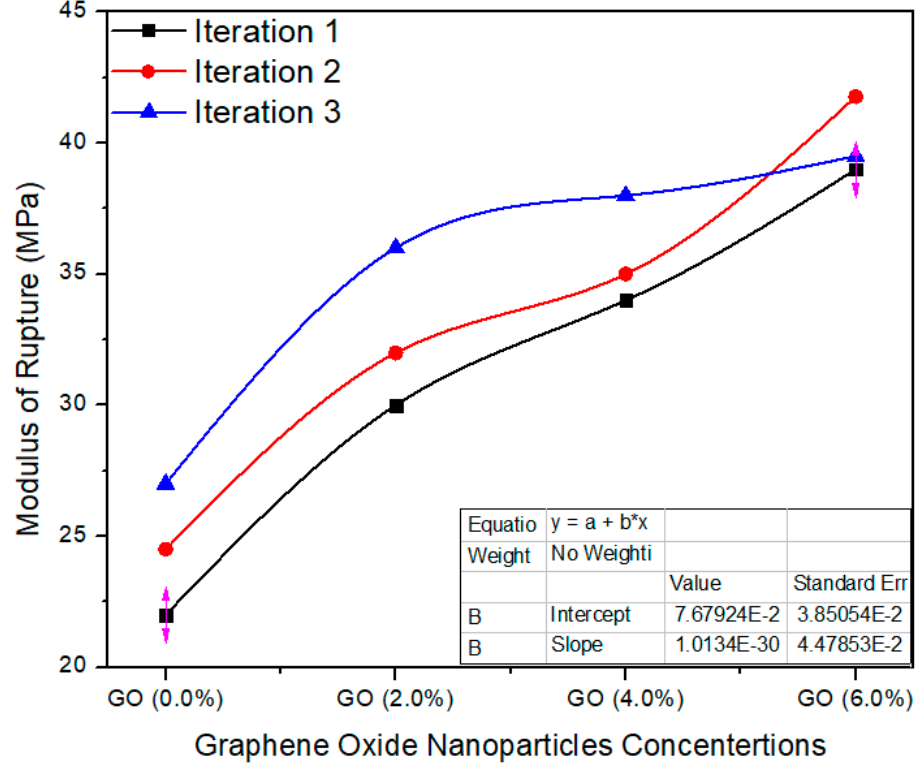
Figure 14. Modulus of rupture vs % values of counts of GO.